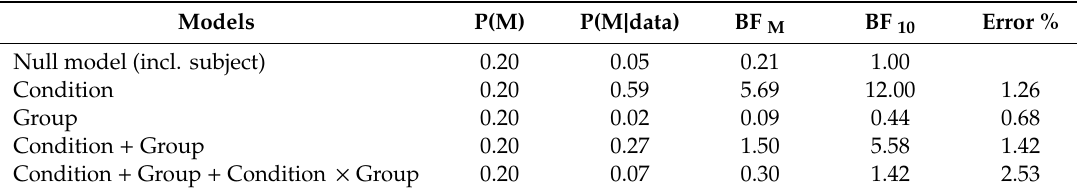
Table 3. 2 × 3 Bayesian ANOVA for MI easiness (two levels: single-gain , competitive-gain ; three levels: training, single, and competitive multi-user